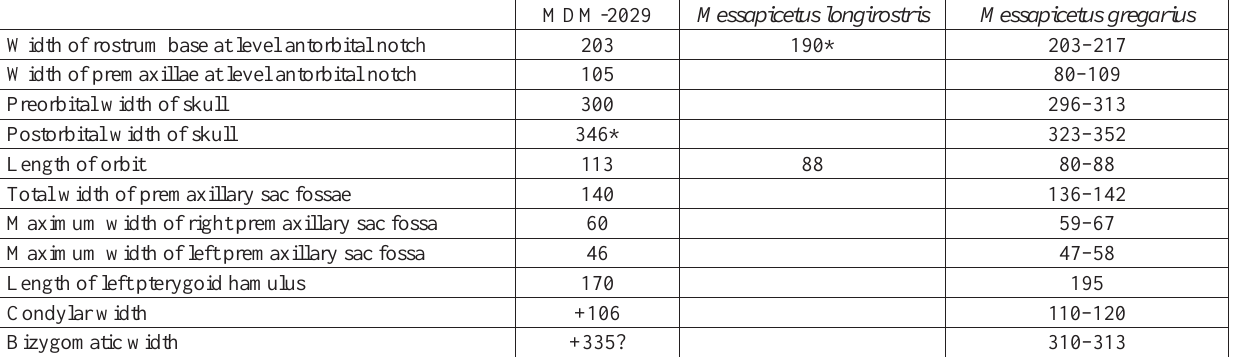
Table 2. Cranial measurements (in mm) of Messapicetus cf. longirostris from the Tortonian of Spain (MDM-2029), Messapicetus longirostris from Italy, and Messapicetus gregarious from Peru. Asterisk indicates doubling of measurement from one side.